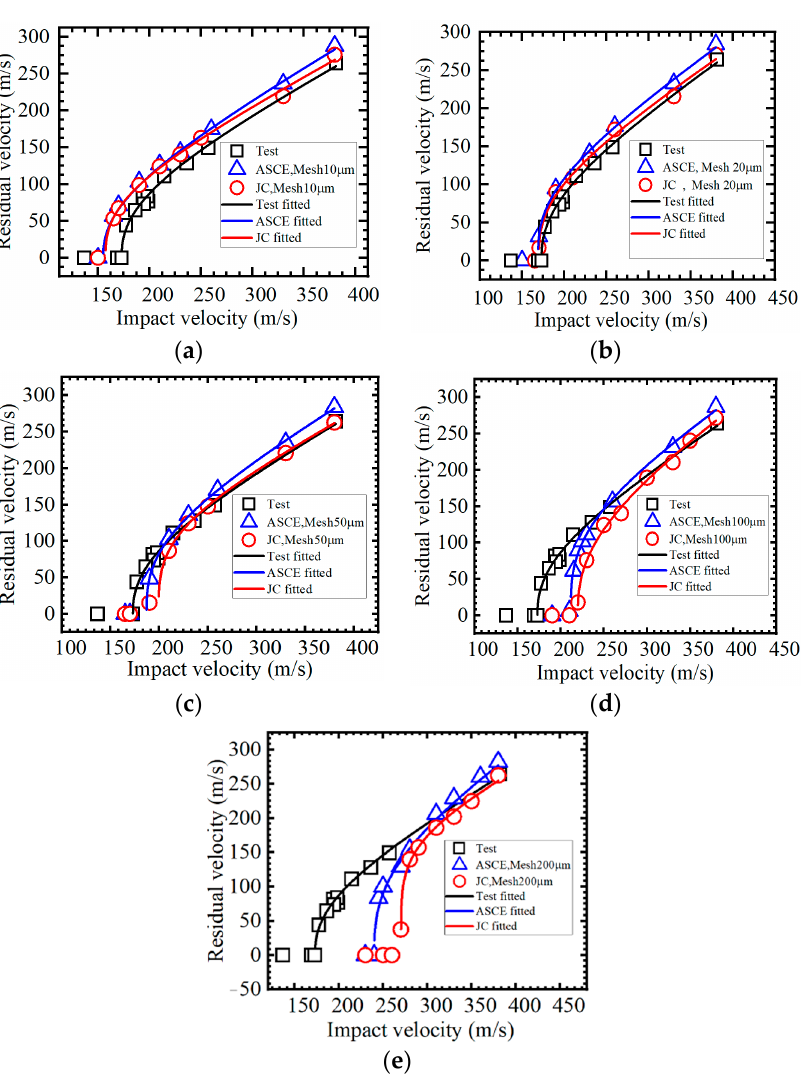
Figure 9. Numerical simulation results of ballistic limit velocity with different element sizes. ( a ) Mesh